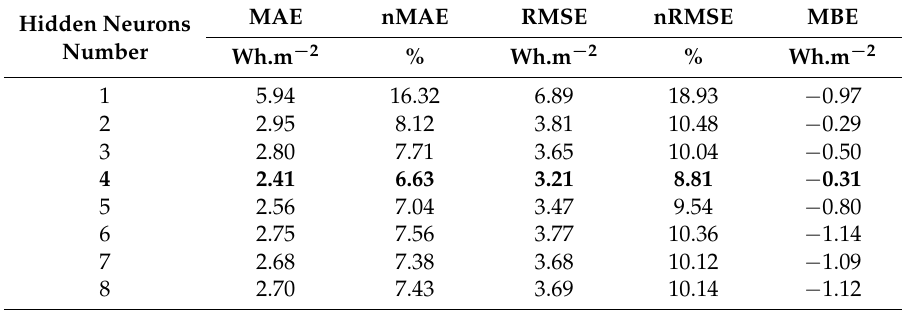
Table 5. Average statistical parameters between measured and estimated global solar 5 min-irradiation on a 36.8° tilted plane for the station of Bouzareah. The bold line is the results for the best architecture. Hidden